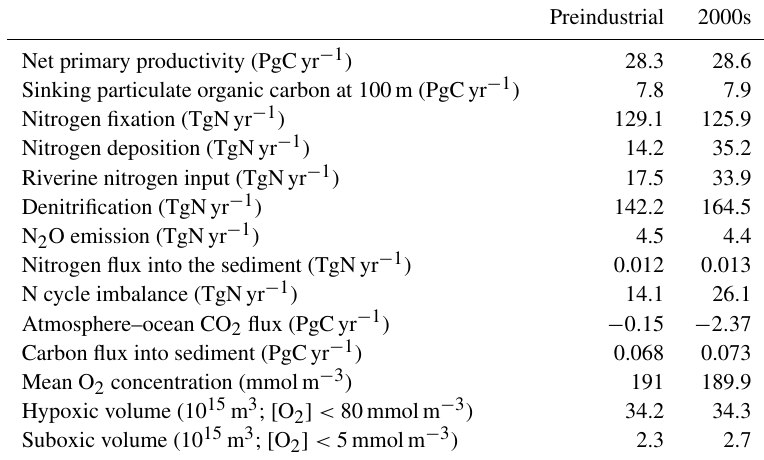
Table 4. Key global ocean biogeochemical fluxes and concentrations under the preindustrial control simulation and the